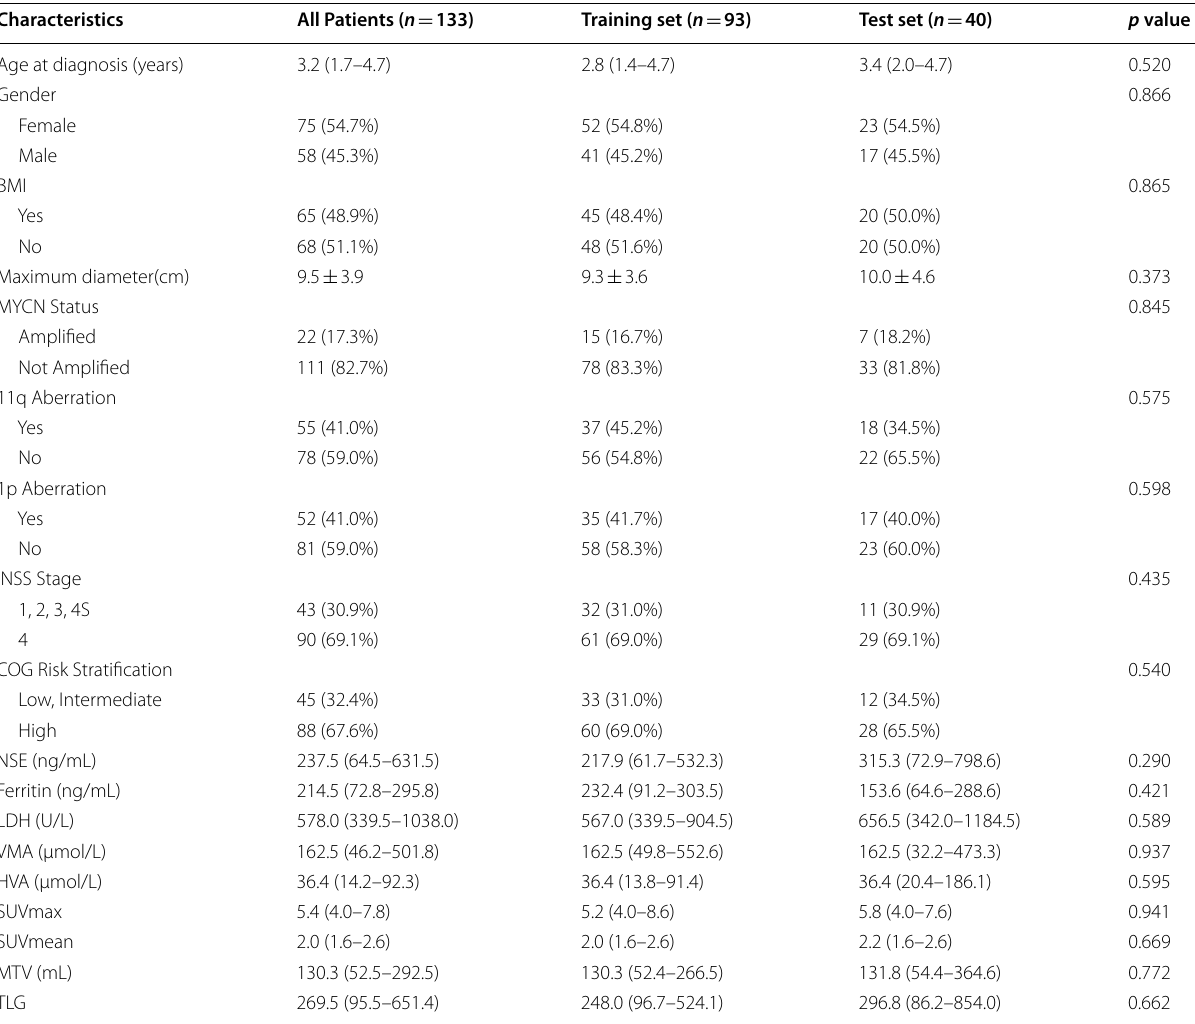
Table 1 Characteristics of patients with neuroblastoma in the training set and test set